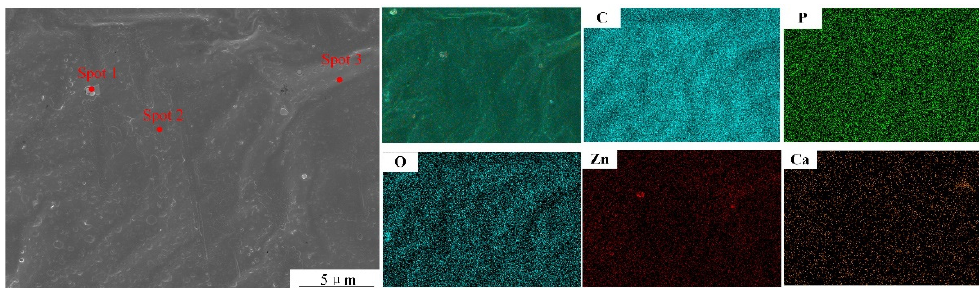
Figure 8. Secondary electron image and element distribution of ZnO-HAP (65 wt.% ZnO + 35 wt.% HAP)/epoxy coating.